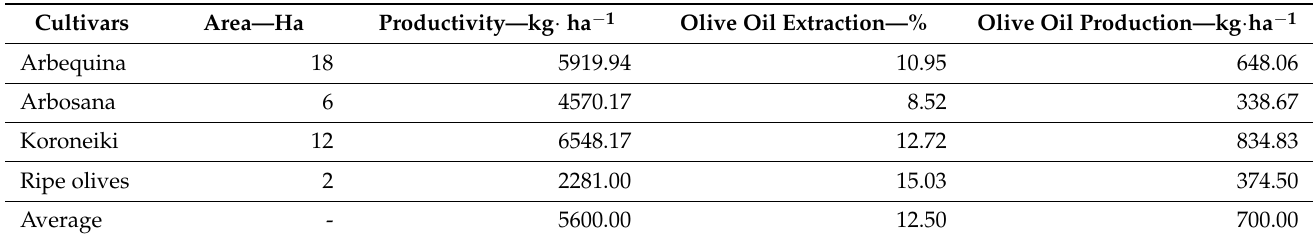
Table 2. Olive yield and percentage of EVOO extraction by EVOO AGS cultivars in southern Brazil.